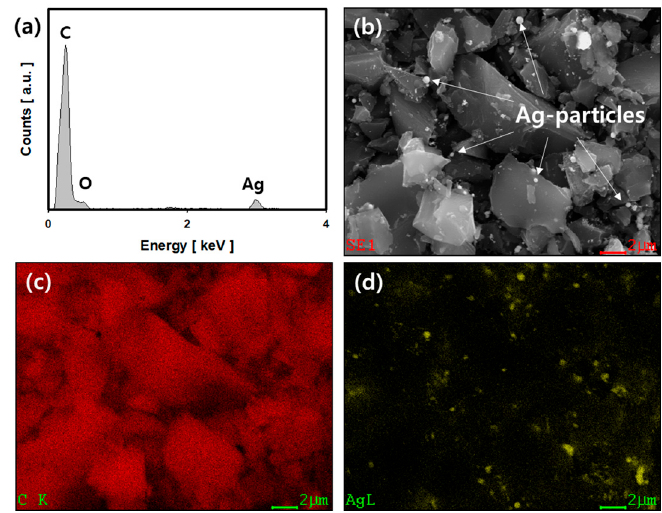
Figure 3. Analysis results of FE-SEM and EDS of Ag/ACF-15 composite prepared by the LPP method: ( a ) EDS spectrum, ( b ) FE-SEM real image and ( c ) carbon element mapping image, and ( d ) Ag element mapping image.